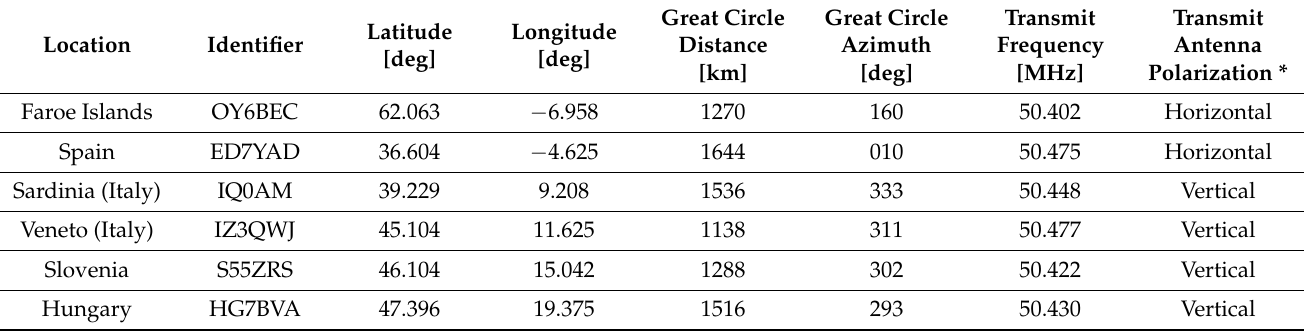
Table 1. Amateur radio beacons observed during the 2018 measurement